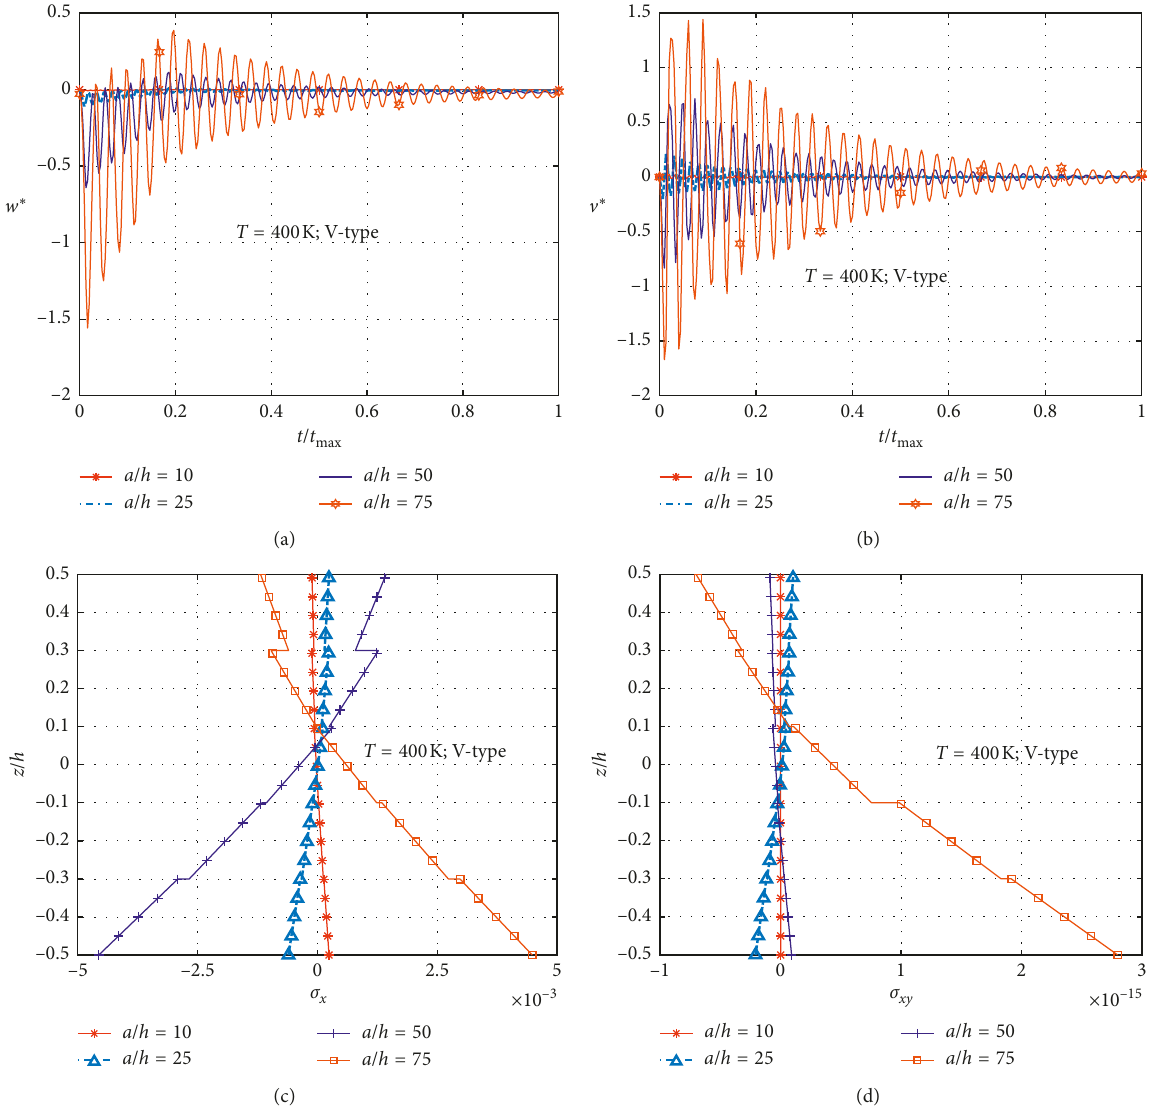
400 K of V-type shell: (cid:31)